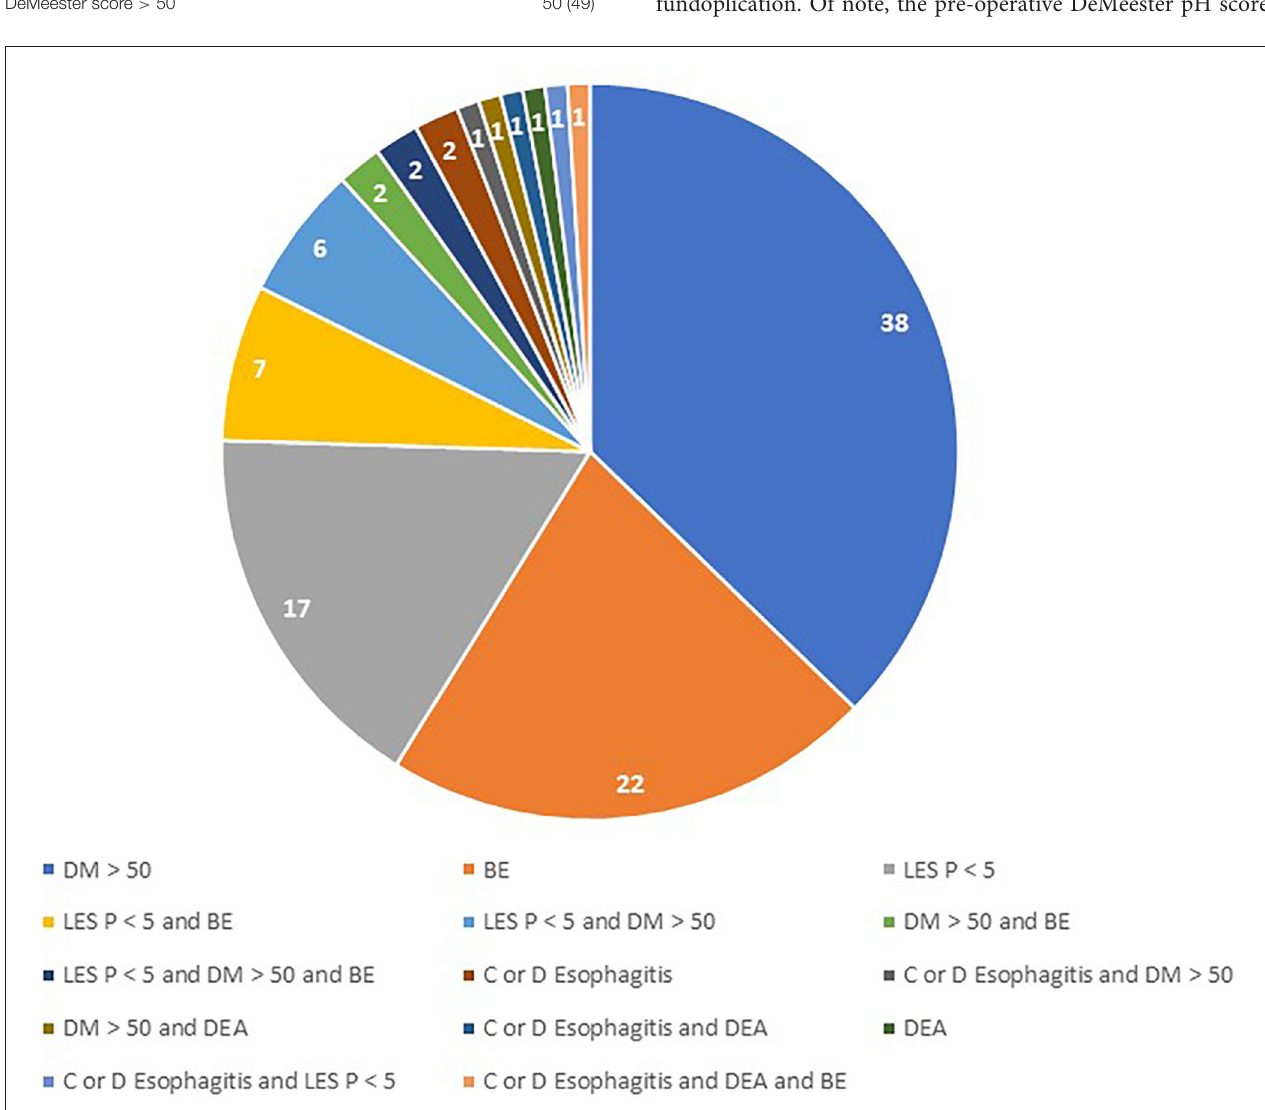
FIGURE 1 | Combination of pre-operative abnormalities in patients with severe GERD. DM, DeMeester Score; BE, Barrett’s Esophagus; LES P, LES residual pressure; DEA, Distal esophageal